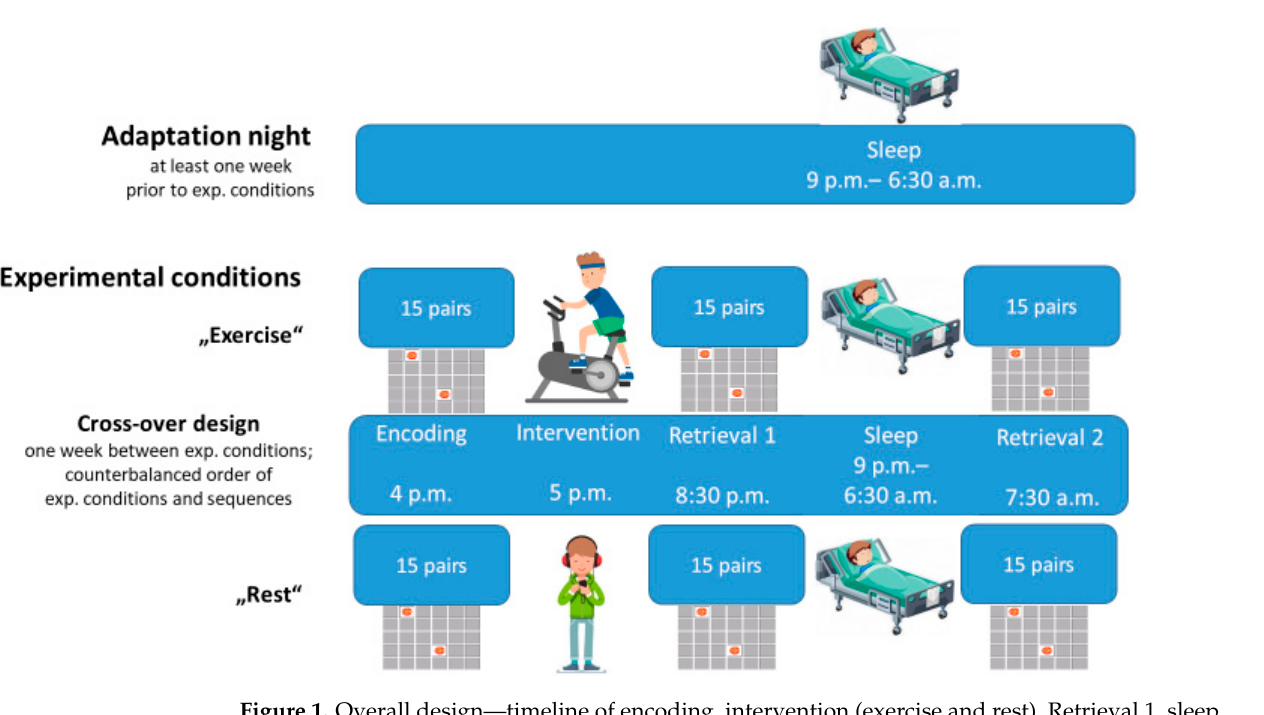
Figure 1. Overall design—timeline of encoding, intervention (exercise and rest), Retrieval 1, sleep, and Retrieval 2 (adopted from [40]).